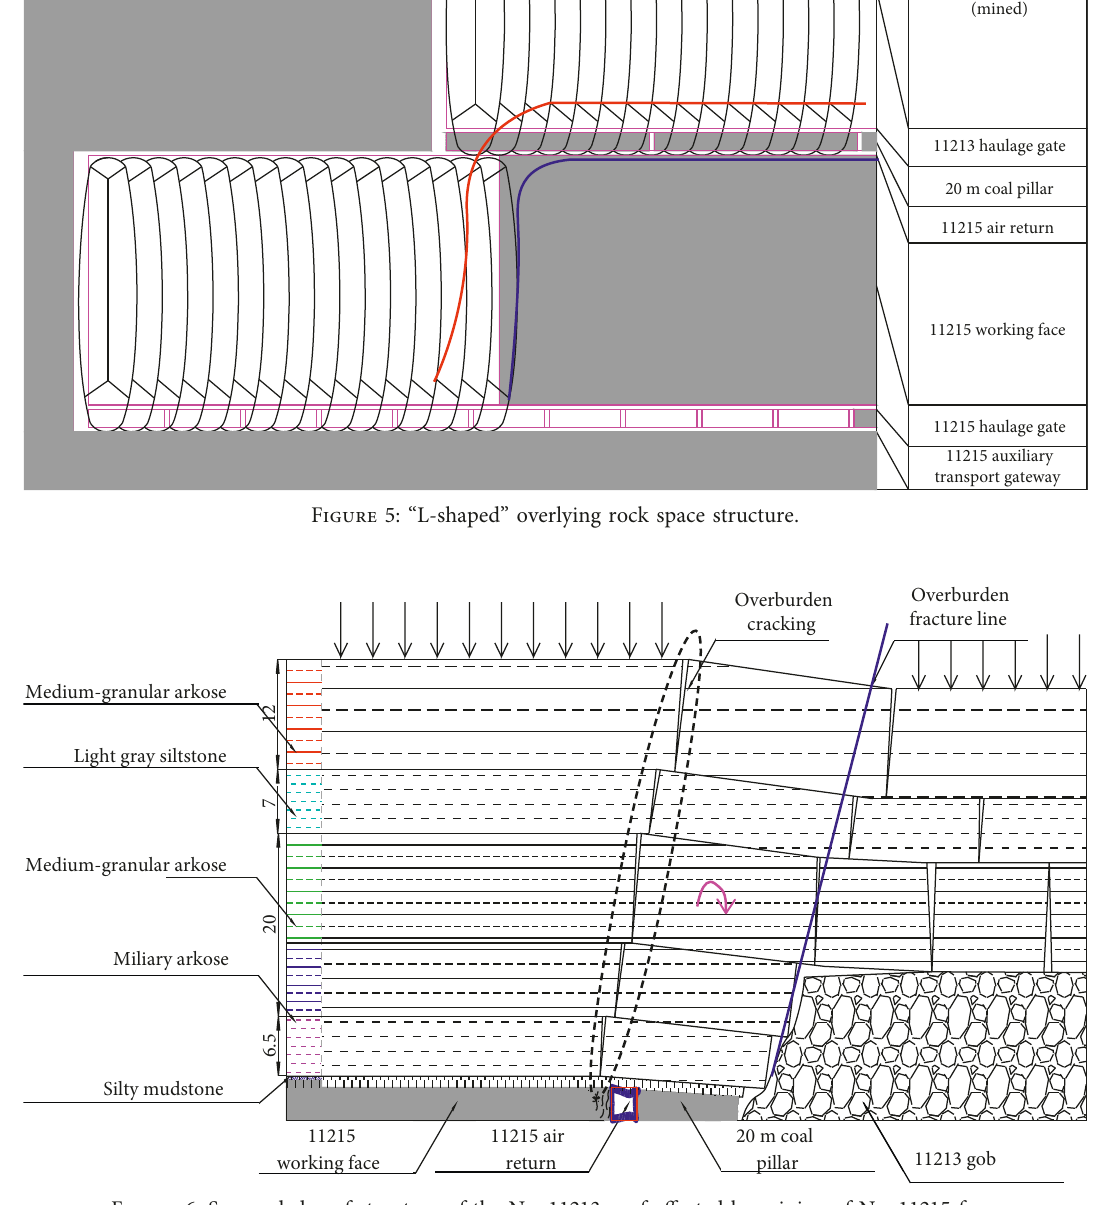
Figure 6: Suspended roof structure of the No. 11213 goaf affected by mining of No. 11215